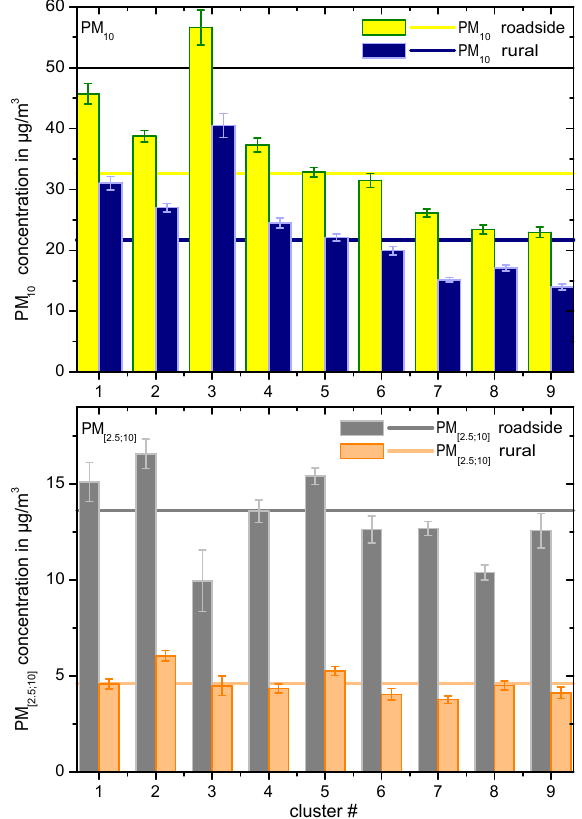
Fig. 9. PM 10 and PM [ 2 . 5 ; 10 ] concentration at roadside and regional background as well as standard deviation for each cluster. Horizon- tal lines indicate overall averages for a particular parameter.